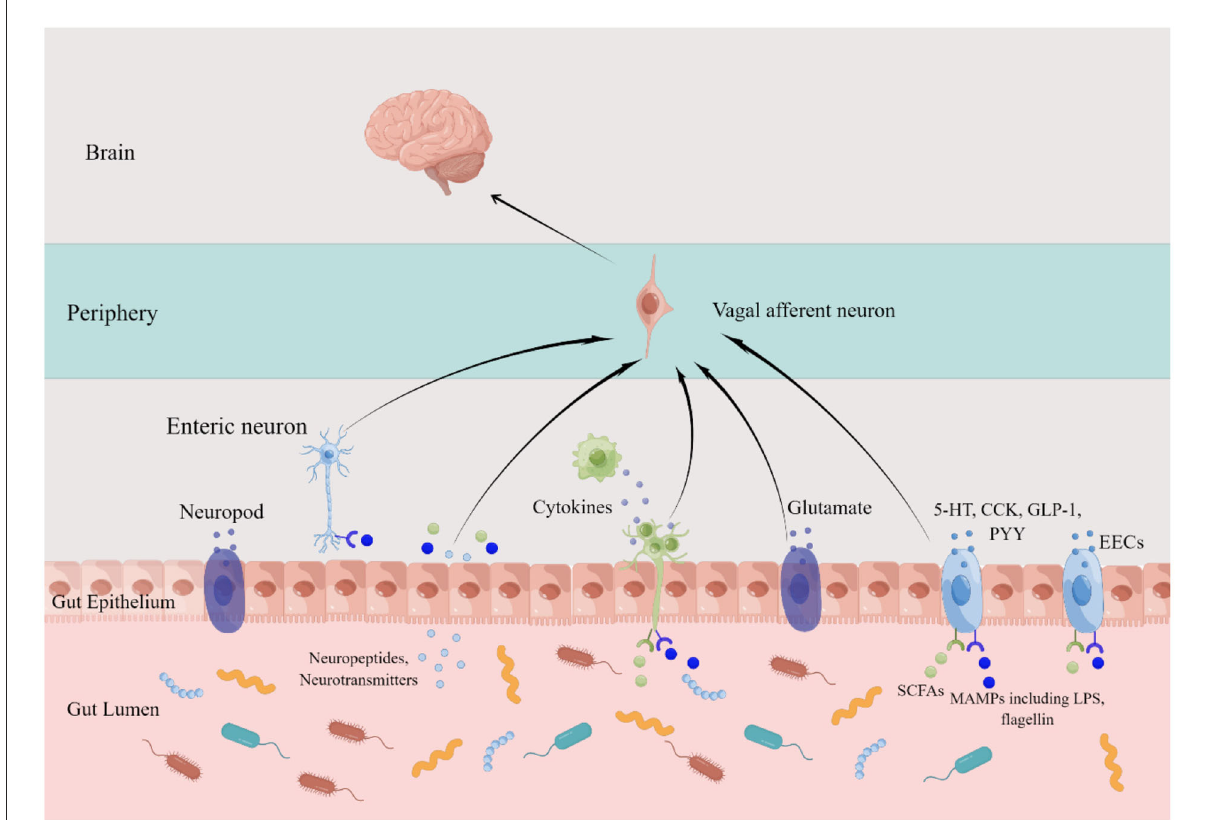
FIGURE1 Vagal afferents transmit signals from gut microbiota to the central nervous system. 5-HT, serotonin; CCK, cholecystokinin; GLP-1, glucagon-like peptide-1; PYY, peptide YY; EECs, enteroendocrine cells; SCFAs, short-chain fatty acids; MAMPs, microbe-associated molecular patterns; LPS, lipopolysaccharide. By